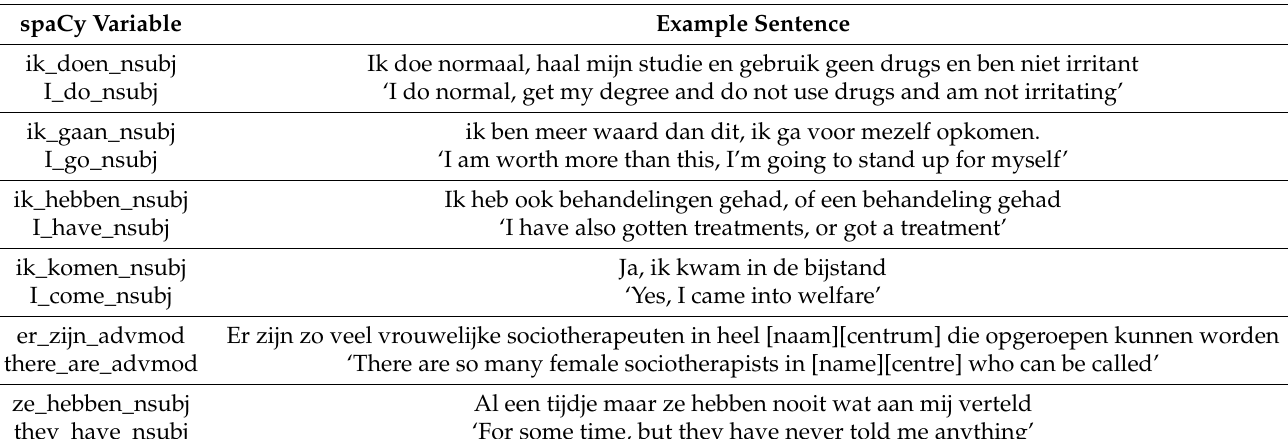
Figure 7. Top 10 SpaCy n-gram features in binary classification. Table 4. Example sentences containing the top 6 spaCy